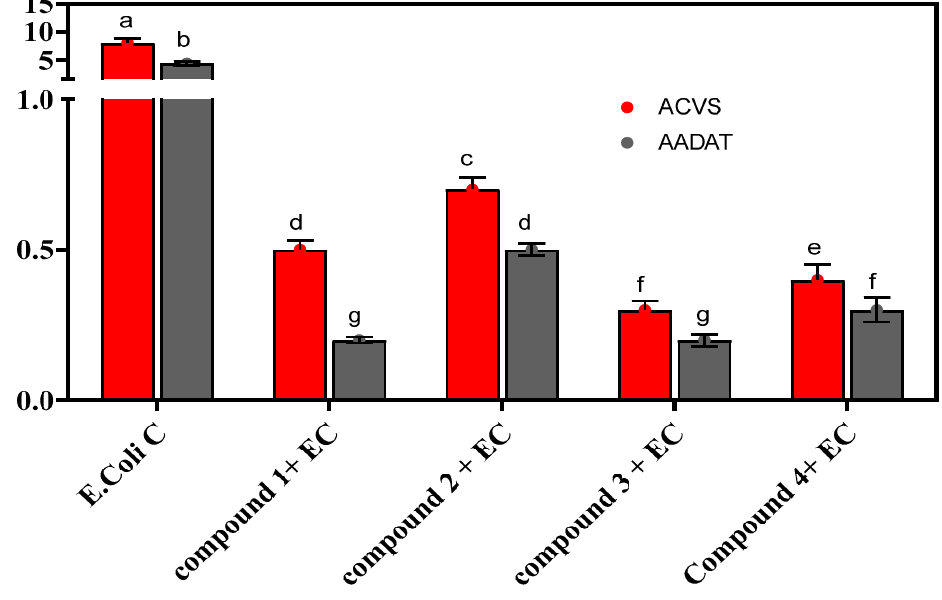
Figure 3. Inhibition of beta-lactam gene ( δ -(l- α -aminoadipyl)-l-cysteinyl-d-valine synthetase (ACVS) and aminoadipate aminotransferase (AADAT)) in E. coli by compounds isolated from bacteria. EC = E. coli . DMRT test was performed for statistically significant variations. Small letters (a to g) show variation across different treatments. Table 2. Antibacterial activity of four compounds isolated from B. subtilis strain EP1 against E. coli .